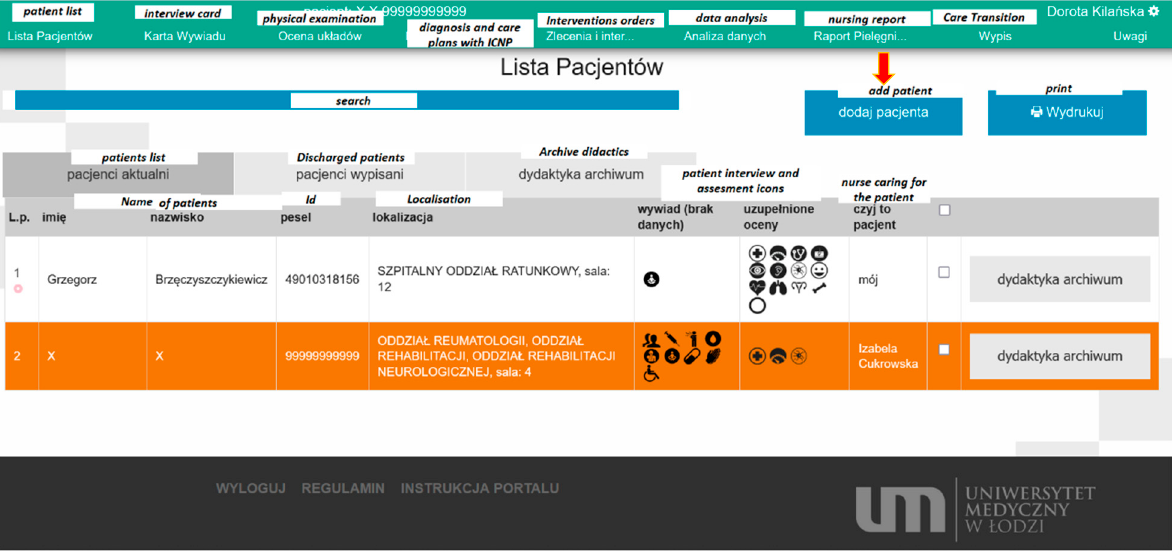
Figure 3. The ADPIECare “Dorothea” system’s user panel; source: https://pielegniarki.umed.pl/lista_pacjentow.html (accessed on on 19 April 2022).